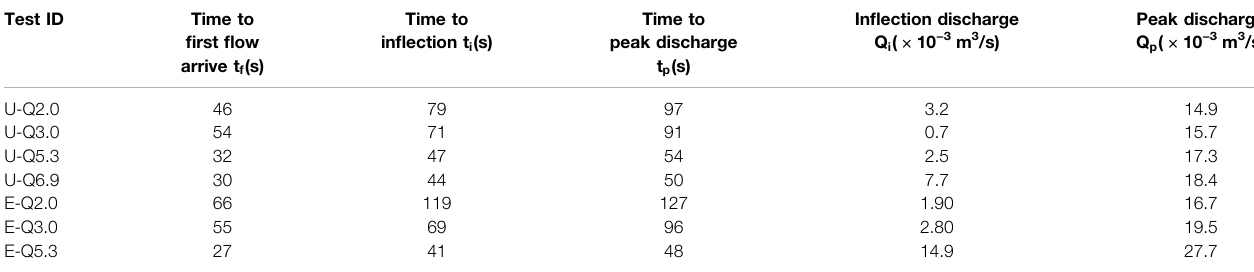
TABLE 3 | Characteristic timescales and discharges for each test.